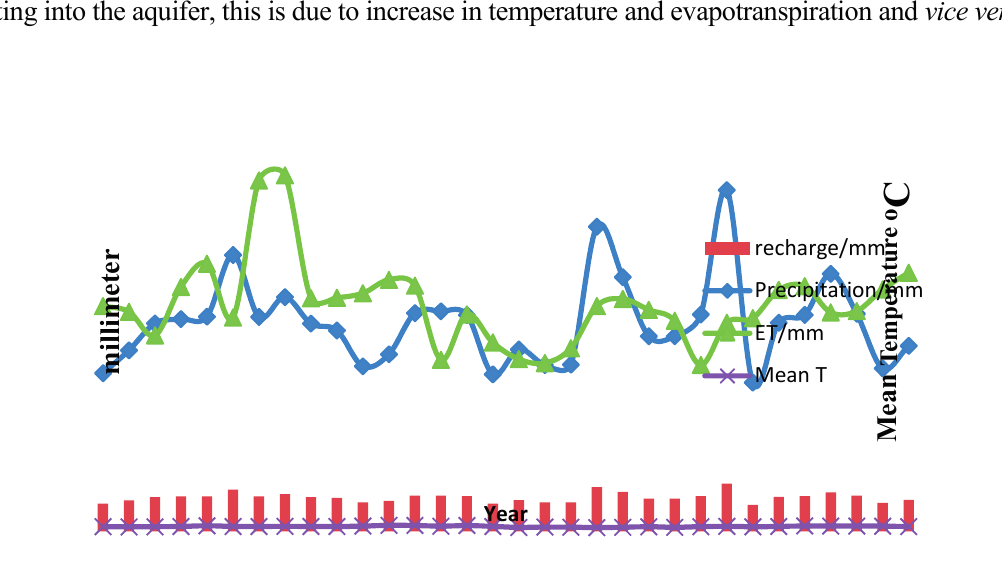
Figure 2. Total annual precipitation, groundwater recharge, evapotranspiration, and temperature.